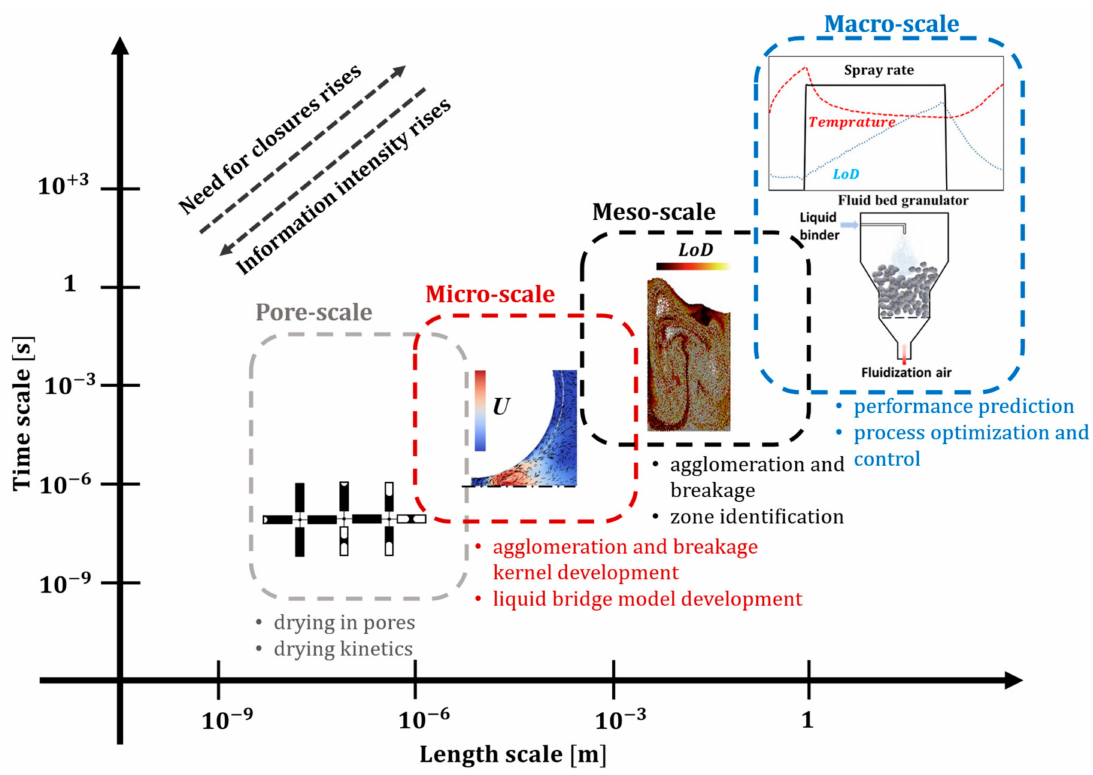
Figure 6. Scales when modeling and simulating granulation processes with a focus on